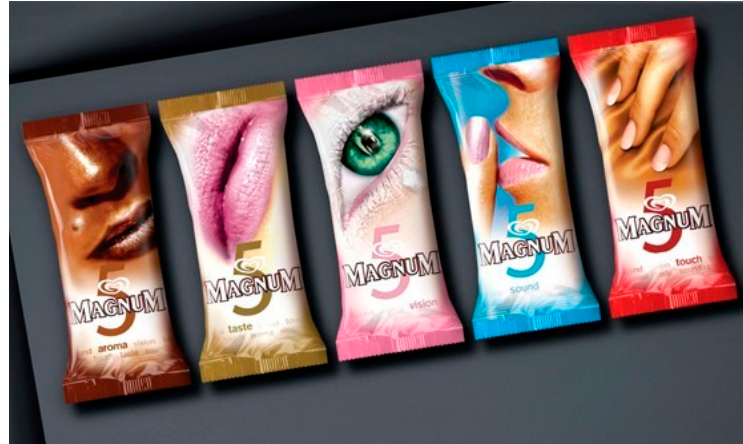
Figure A1. Magnum 5 Senses campaign by Unilever © Magnum.